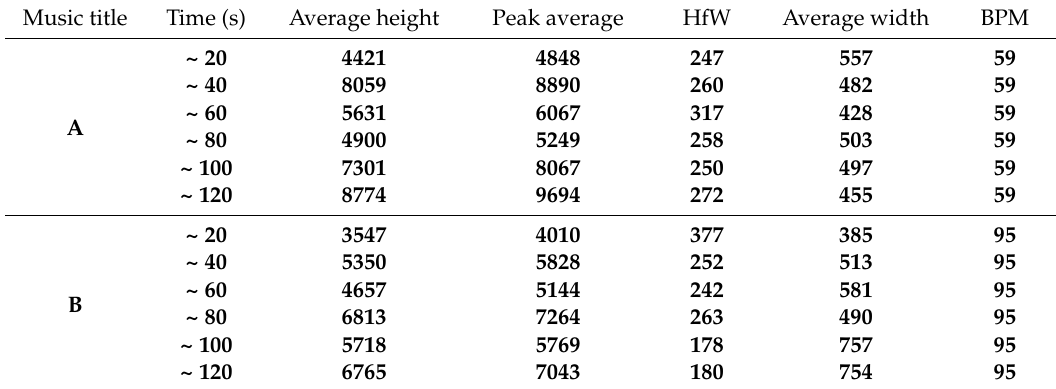
Table 2. Collected music data.